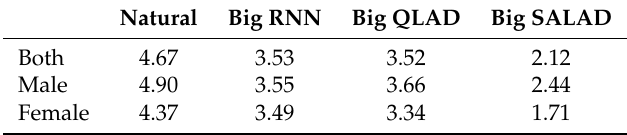
Figure 2. Evolution of test distortions depending on the available amount of training data (in percentage), for both male ( left ) and female ( right ) big models. Table 3. Subjective mean opinion scores, for both speakers, male and female. Higher values are